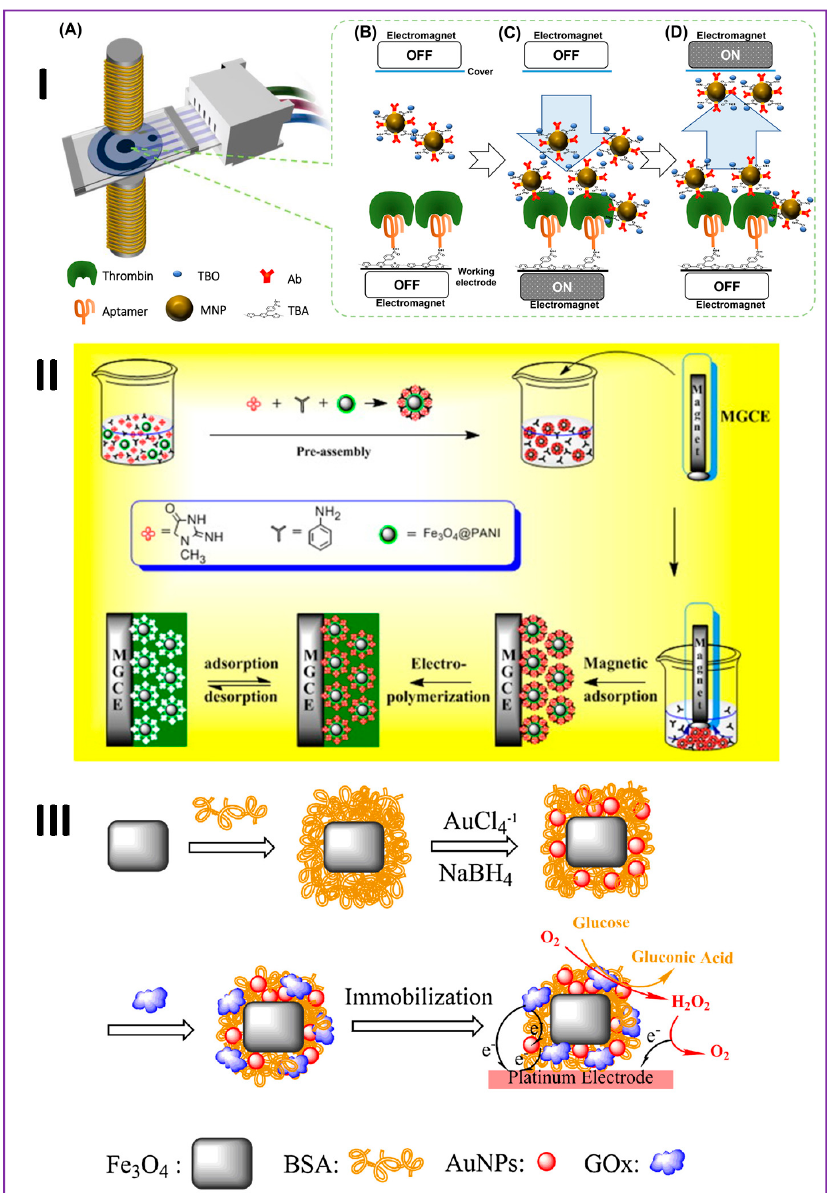
Figure 1. ( I ) ( A ) Sensing system composed of an electrochemical sensor, a pair of electromagnets, and a sample chamber. ( B – D ) The process of magnetic force-assisted electrochemical sandwich assays (MESA) is illustrated: ( B ) the sample loading step to mix the sample solution and the magnetic nanoparticle (MNP) bioconjugates with antibody and toluidine blue O (MNP@Ab-TBO); ( C ) the reaction step to form sandwich complexes on the electrode surface; and ( D ) the removal step to remove unbound MNP@Ab-TBO from the electrode surface. Reproduced with permission from Reference [57]. Copyright 2018 Elsevier. ( II ) Schematic representation of the preparation of the molecularly imprinted electrochemical sensor (MIES) for detection of creatinine. Reproduced with permission from Reference [58]. Copyright 2014 Elsevier. ( III ) Schematic illustration of the preparation of a GOx/AuNPs/BSA/Fe 3 O 4 /Pt electrode. Reproduced with permission from Reference [59]. Copyright 2016 Elsevier. Abbreviations: TBA - 2,2´:5´,5 ″ -terthiophene-3´-p-benzoic acid; MGCE - magnetic glassy carbon electrode; Fe 3 O 4 @PANI - magnetite@ polyaniline; BSA - bovine serum albumin; AuNPs - gold nanoparticles; GOx - glucose oxidase.